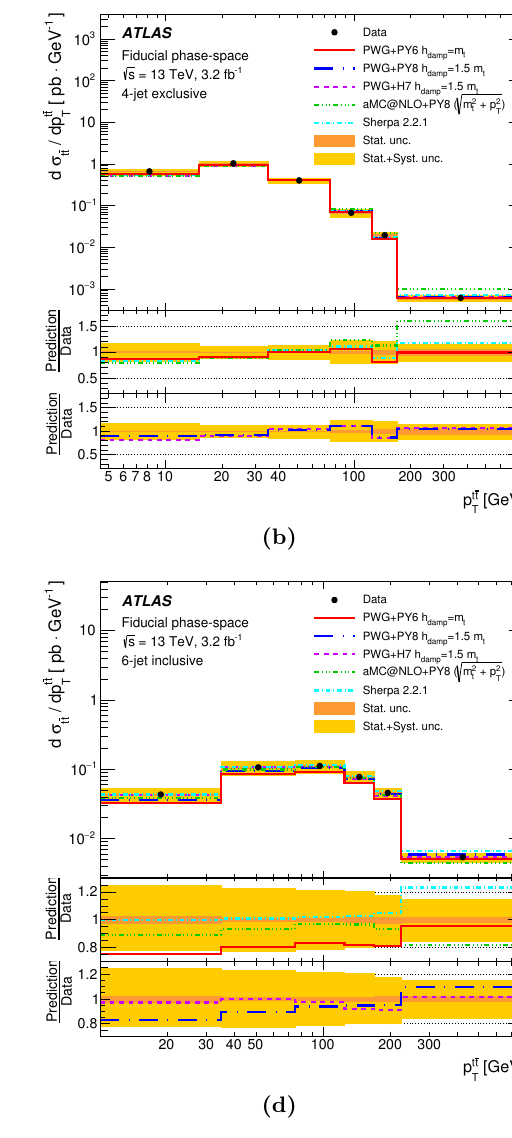
Figure 9 . Di(cid:11)erential cross sections in the (cid:12)ducial phase space as a function of p t (cid:22) t in the 6-jet inclusive con(cid:12)guration, absolute (b) in the 4-jet exclusive, (c) 5-jet exclusive and (d) 6-jet inclusive con(cid:12)gurations. The shaded area represents the total statistical and systematic un-